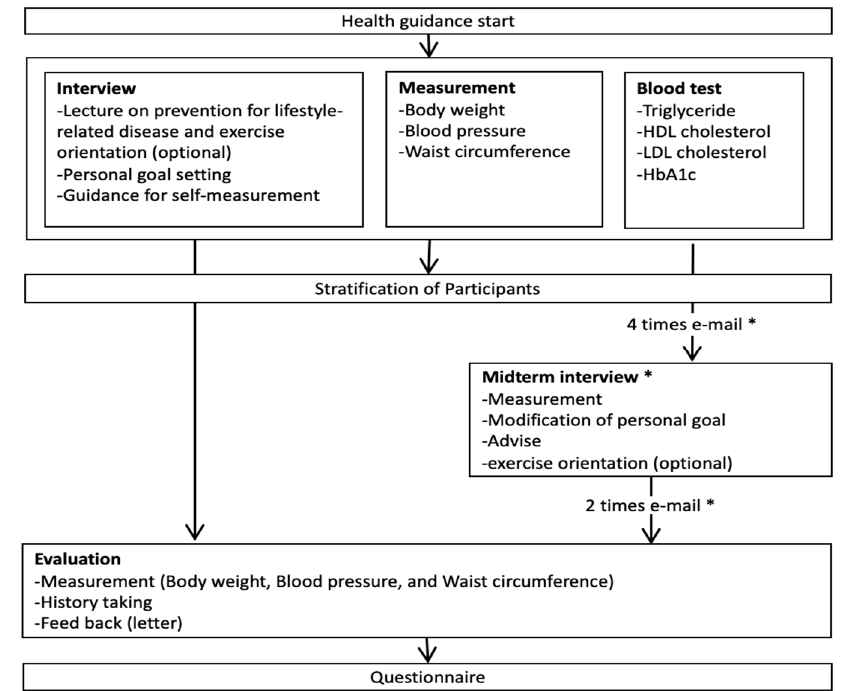
Figure 2. Health guidance program in this study. Note: * IHG program only; HDL: high-density lipoprotein; LDL: low-density lipoprotein; HbA1c: glycated hemoglobin.